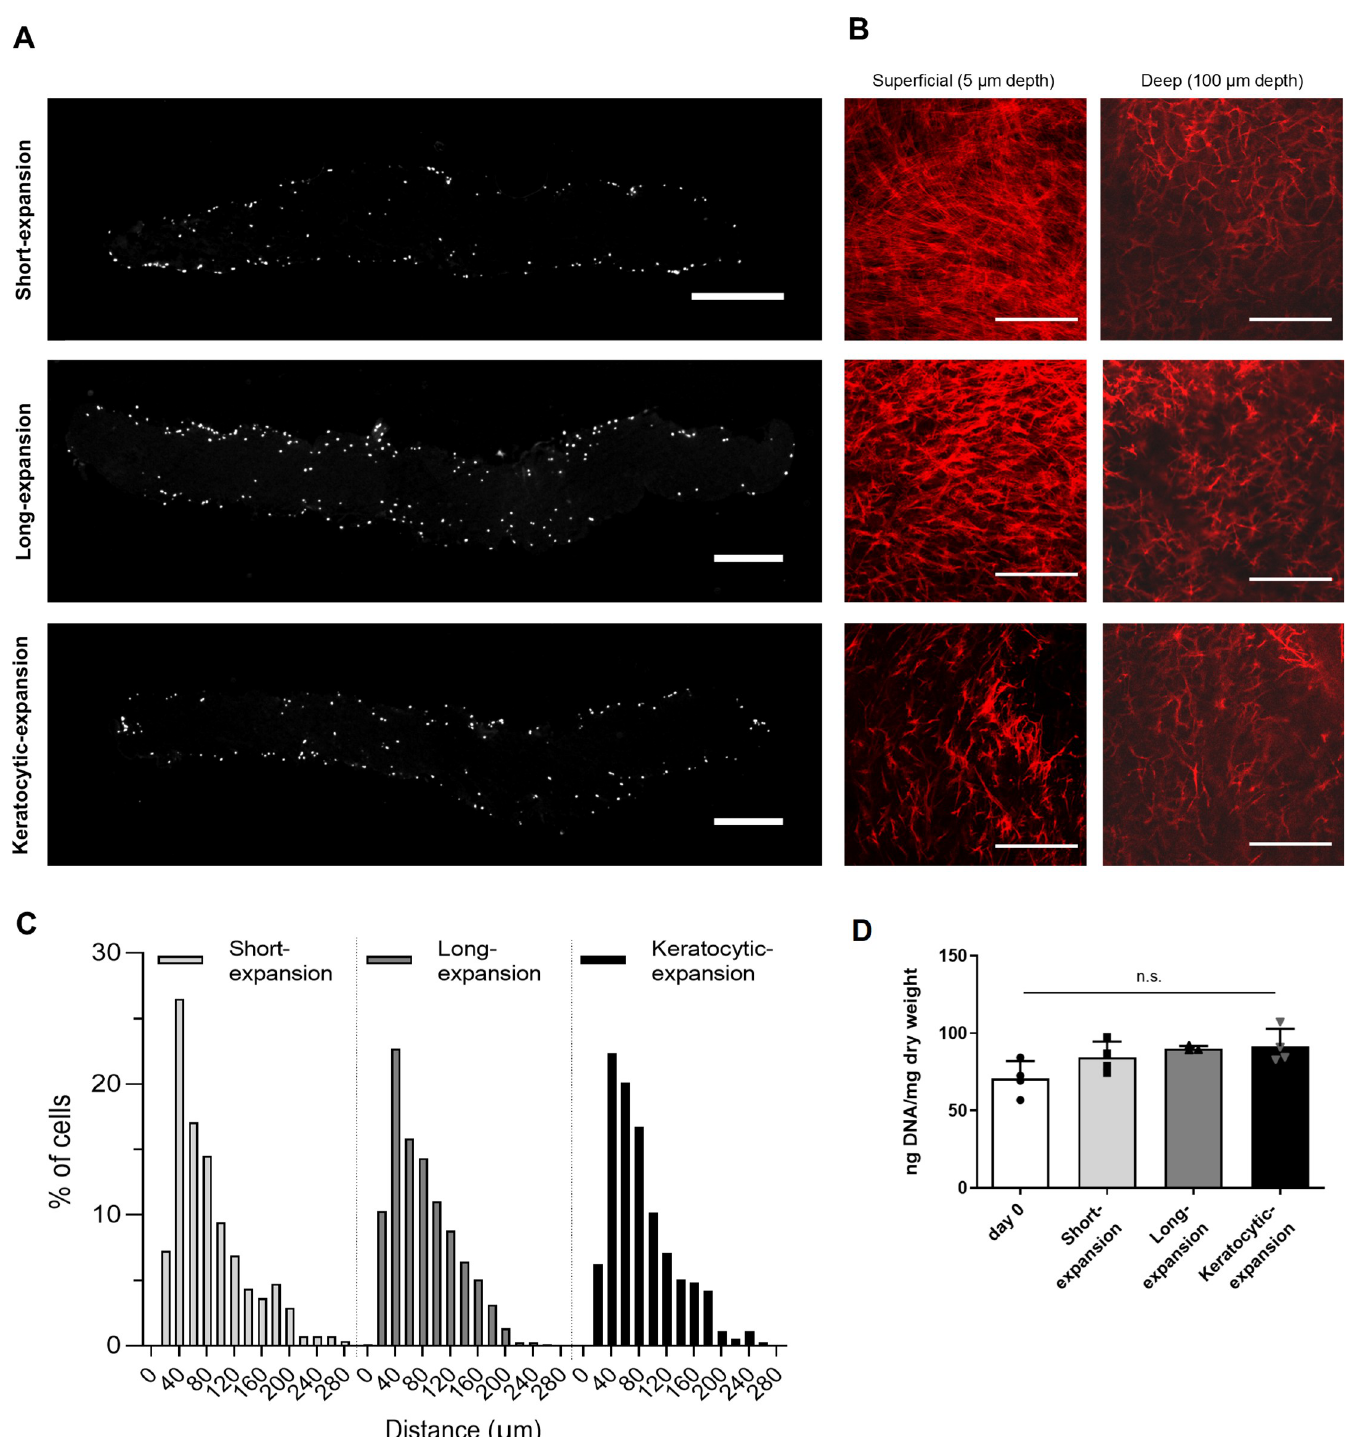
Fig 3. Analysis of the effectiveness of recellularizing scaffold with human keratocytes. A) Longitudinal sections of recellularized scaffolds of keratocytes stained with DAPI nuclear staining following 14 or 28 days of serum culture (short and long expansion), or 14 days of serum culture then 14 days without serum (keratocytic expansion). Scale bar = 500 μ m. B) Actin staining of keratocytes at a superficial depth (5 μ m), and deep depth (100 μ m). Scale bar = 200 μ m. C) Quantification of number of keratocytes grouped by distance migrated from the surface of the scaffold. D) Cell quantification of recellularized scaffolds by total DNA (n.s. = not